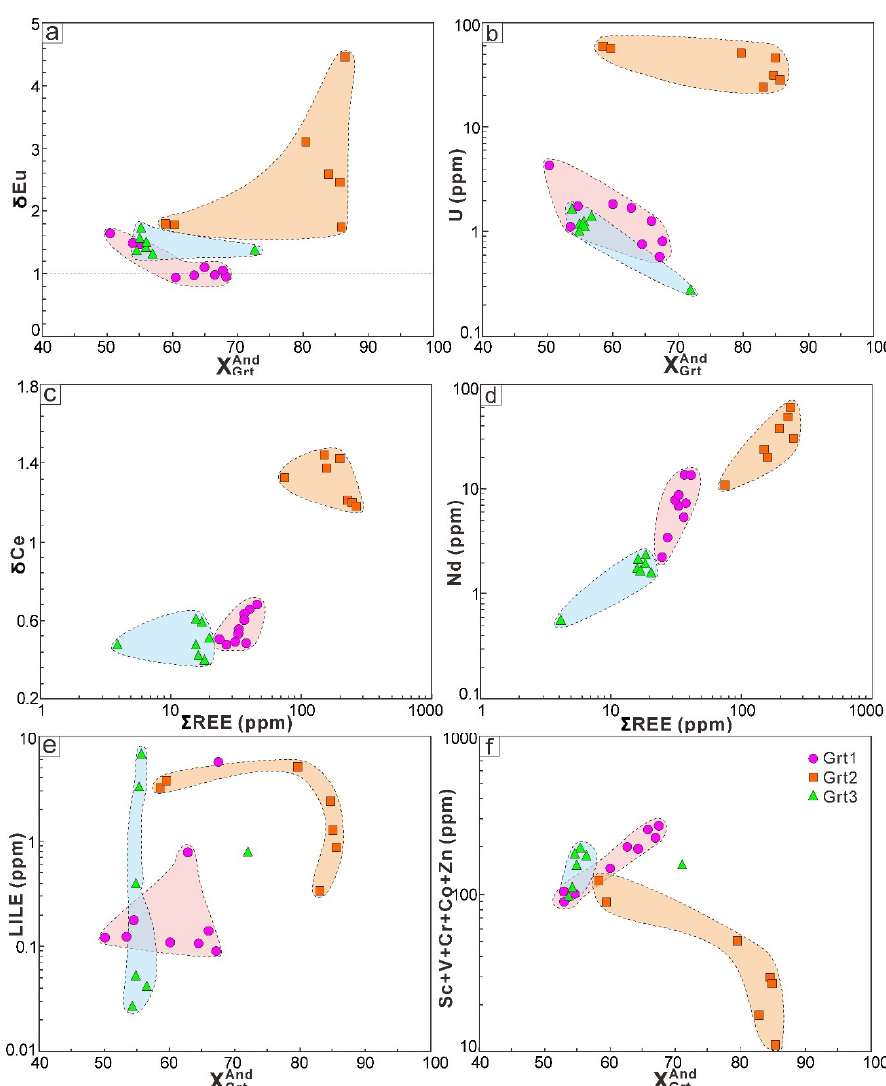
Figure 15. Binary plots of ( a ) proportions of andradite in garnet versus Eu anomalies (δEu), ( b ) proportions of andradite in garnet versus U, ( c ) ΣREE versus δCe, ( d ) ΣREE versus Nd, ( e ) proportions of andradite in garnet versus large ion lithophile elements (LILE), and ( f ) proportions of andradite in garnet versus siderophile elements (sum of Sc, V, Cr, Co, and Zn) for garnets from the Yamansu deposit.